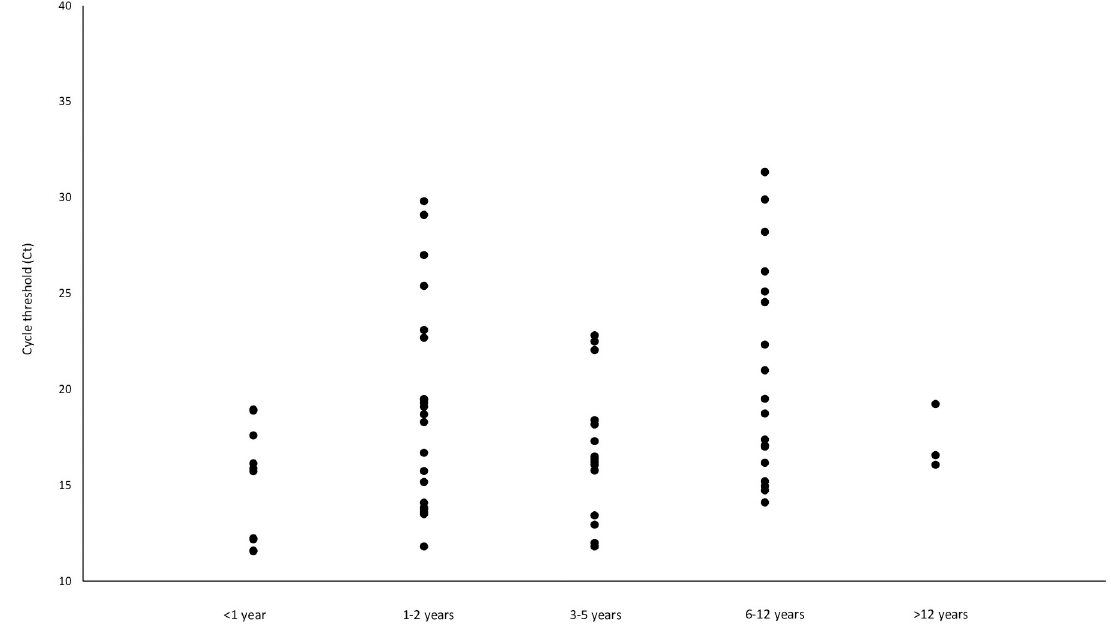
Fig 1. Cycle threshold (Ct) values of the 68 RT-PCR confirmed SARS-CoV-2 infected pediatric patients aged between 0 and 17 years old (obtained by cobas 1 Liat 1 SARS-CoV-2 & Influenza A/B assay).